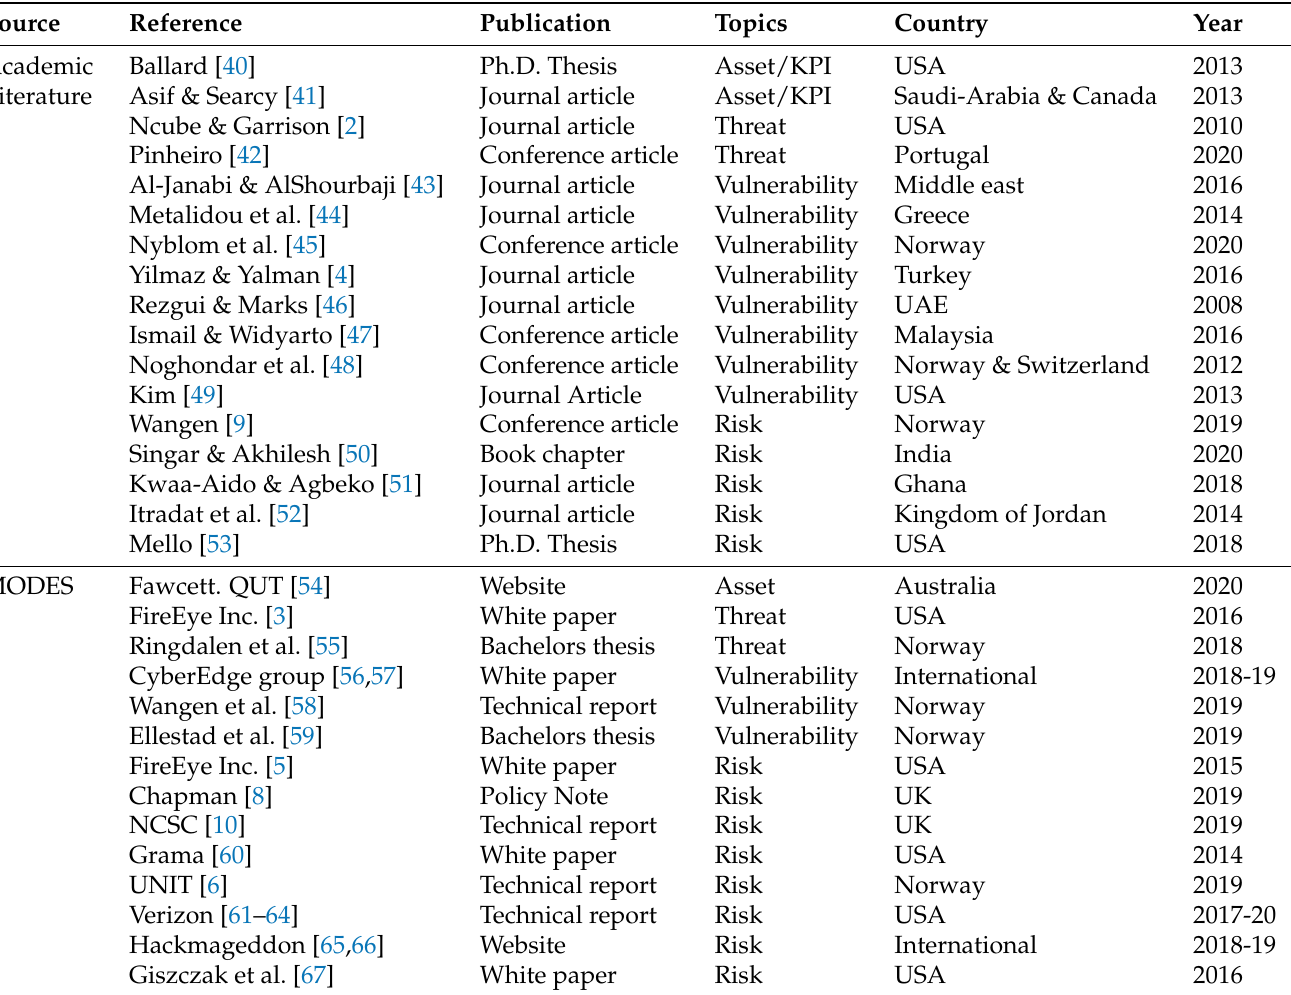
Table 2. Overview of referenced research sorted on publication type, topics, country, and publication